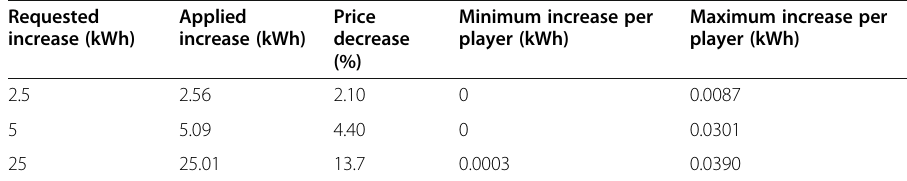
Table 4 Studied load response consumption